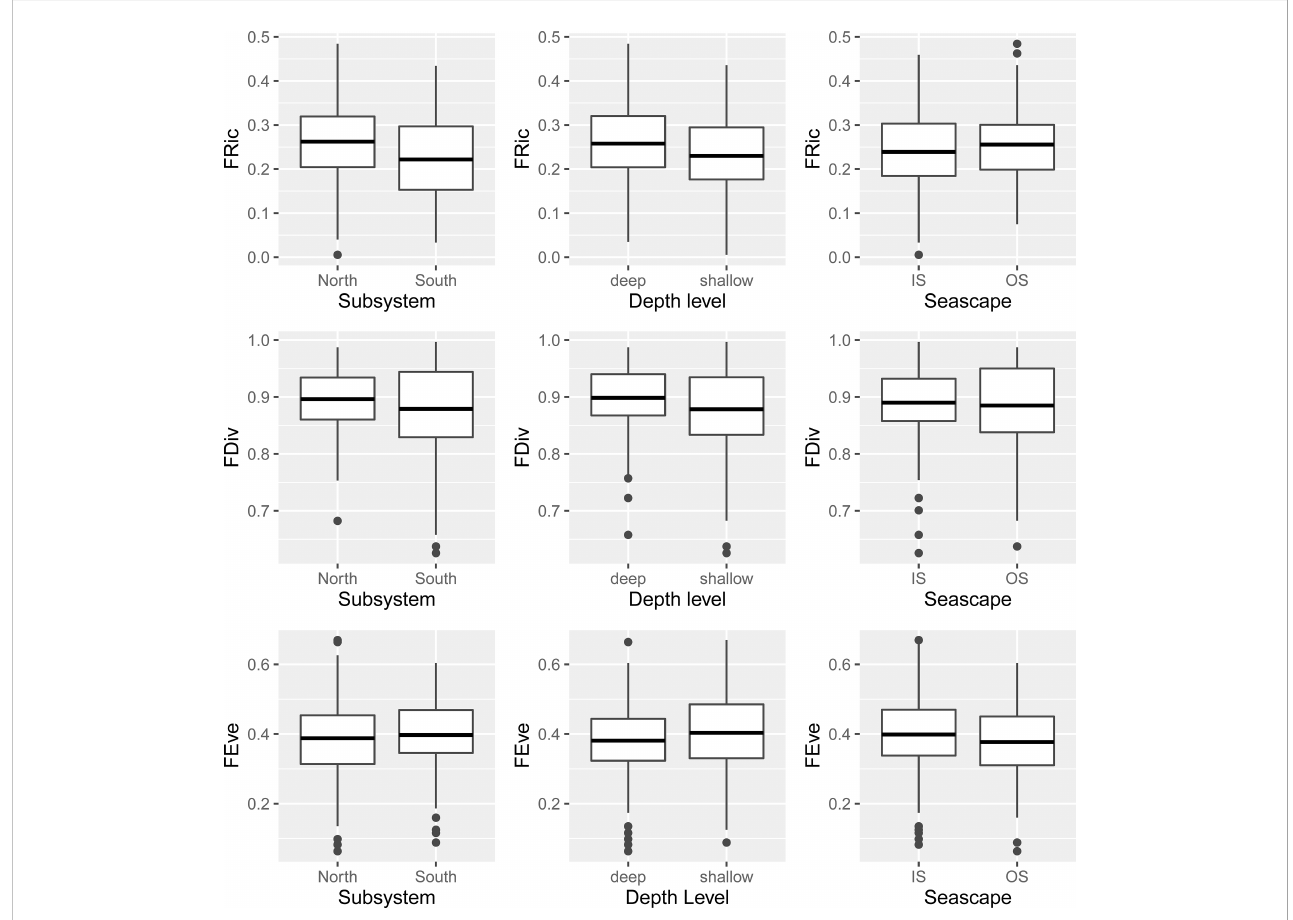
FIGURE 3 Boxplot with spatial variation in functional diversity (FD) metrics by subsystem, depth level, and seascape region; values of FD metrics are express as a mean rather than median. Functional diversity metrics were calculated with four coordinate axes that explained 73.87% of the cumulative total variation of fi sh species in the functional trait space. Functional richness (FRic), divergence (FDiv) and evenness (FEve), Inner Shelf (IS), and Outer Shelf (OS).